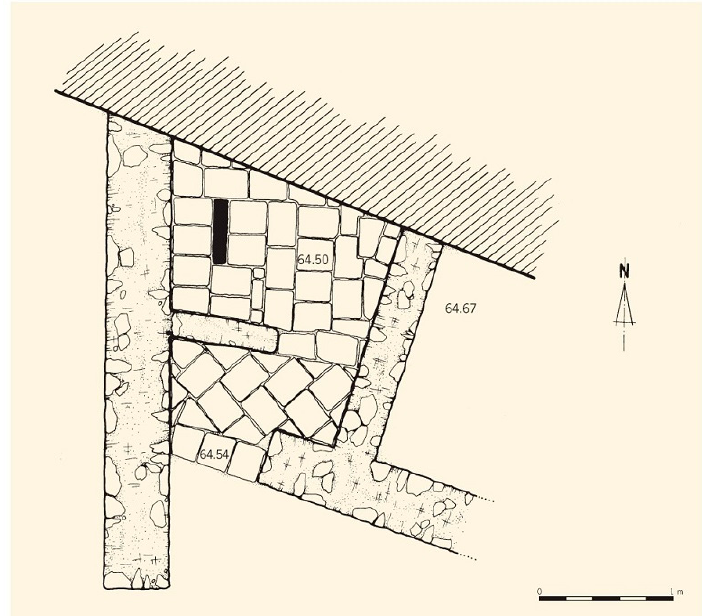
Figure 13. Mértola—house n. 1 (latrine). Figure 13. M é rtola—house n. 1